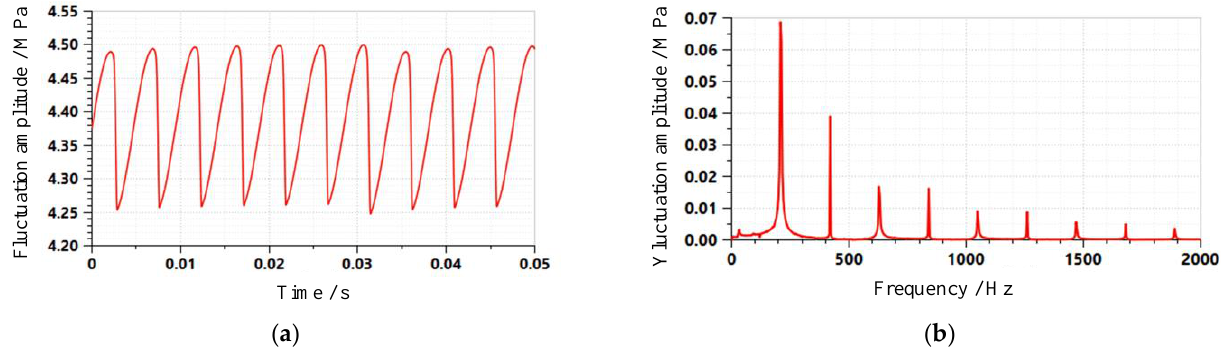
Figure 7. Load pressure ( p 1 = 4.375 MPa) waveform. ( a ) Time domain diagram; ( b ) frequency domain map.